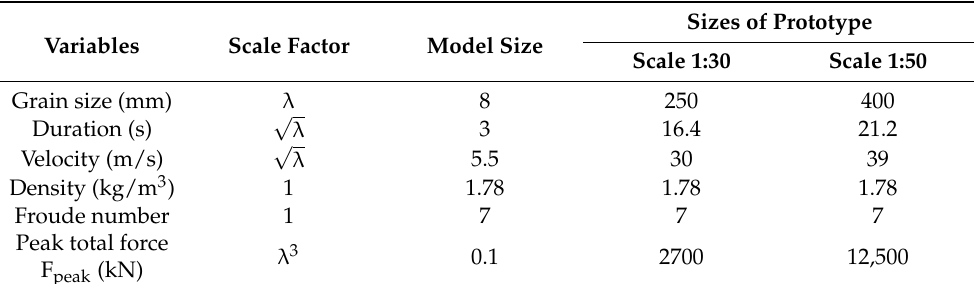
Table 1. Scales of the model experiments depending on physical quantities (grain diameter d, duration t, velocity v, density ρ , Froude number Fr, peak total force F peak